Question: Reading the figure, is the described quantity rising or falling?
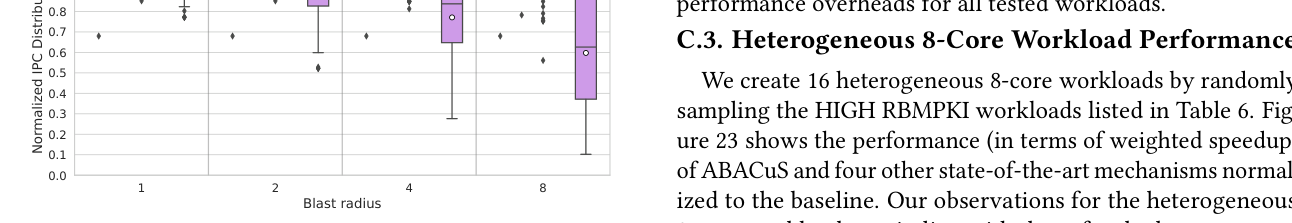
Answer: increasing